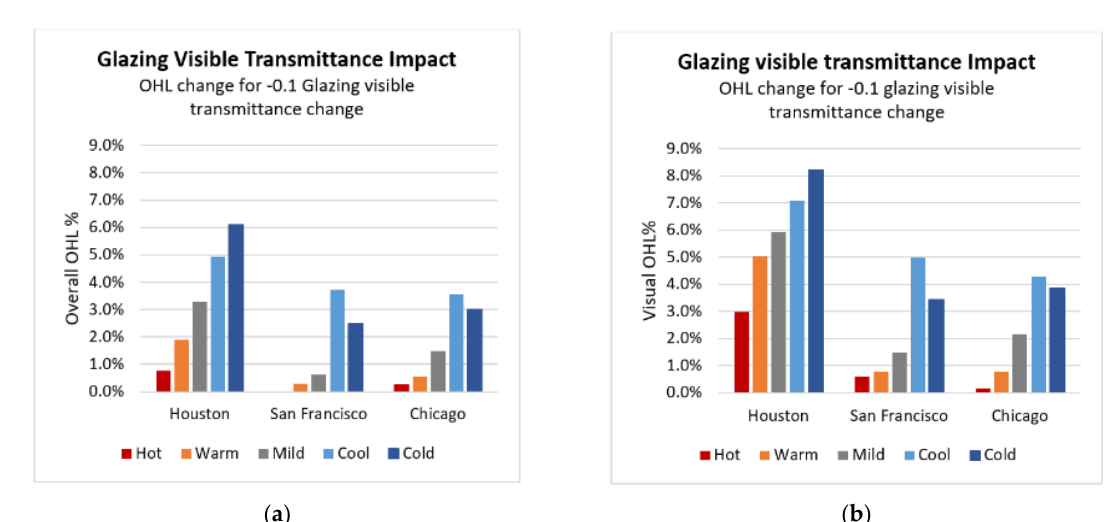
Figure 14. Impact of a 1 W/sq.m decrease in plug loads on overall ( a ) and thermal ( b ) OHL.